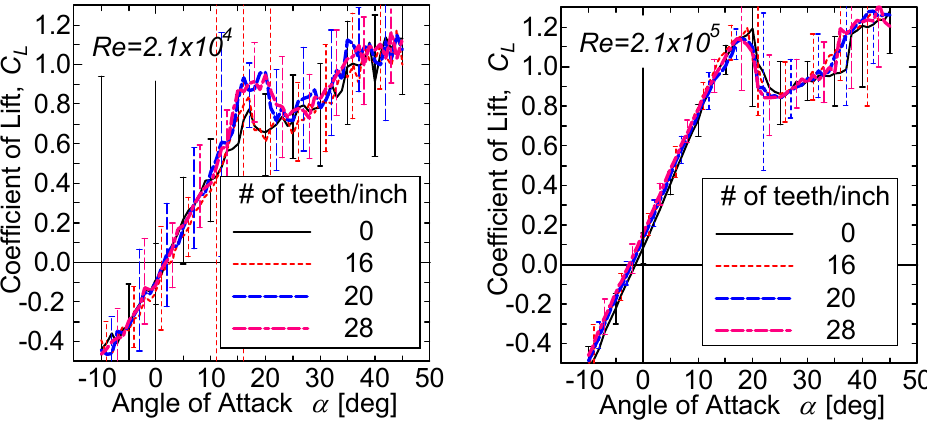
Fig.6(a) C L at U =2m/s, Re =2.1x10 4 Fig.6(b) C L at U =20m/s, Re =2.1x10 5